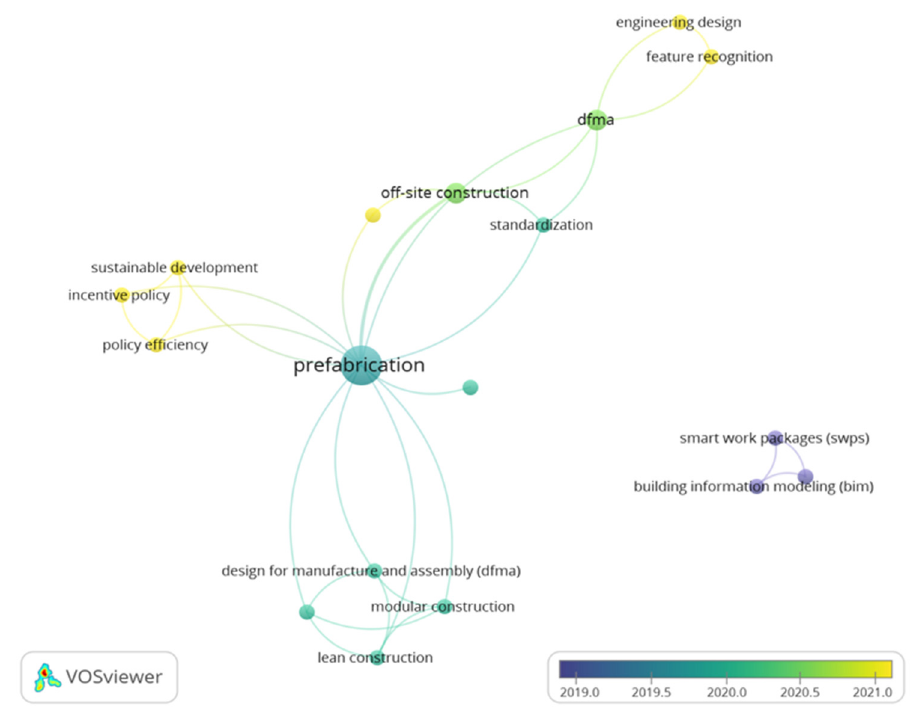
Figure 3. Science mapping of research keywords of referred papers.